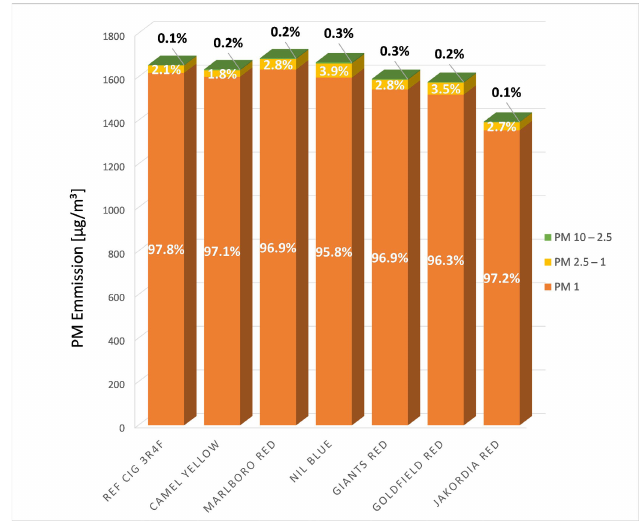
Figure 2. Distribution pattern of the mean concentrations (C mean ) of all cigarette brands investigated. The percentages (rounded to one decimal place) of the particle fractions PM 10–2.5 , PM 2.5–1 , and PM 1 are listed in the respective part of the column diagram. The measured PM values of the six private-label and brand-name cigarette brands each correlated significantly with the calculated filling densities (PM 10 : Pearson r = Int. J. Environ. Res. Public Health 2021 , 18 , x FOR PEER REVIEW −0 .8399, p = 0.036; PM 2.5 : Pearson r = −0 .8397, p = 0.037; PM 1 : Pearson r = −0 .8916, p = 0.017), but not with the ascertained tobacco weights ( p > 0.05). PM 1 correlated significantly with the ascertained filter lengths (Pearson r = −0 .8237, p = 0.044). Here, the correlation was not significant for PM 10 and PM 2.5 ( p > 0.05). Figure 3 shows the correlations (Pearson) of measured PM mean concentrations with ascertained filter lengths and calculated filling densities of the private-label and brand-name cigarettes.